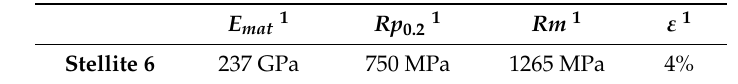
Table 2. Nominal values of stress at room temperature of the Stellite 6 spray.